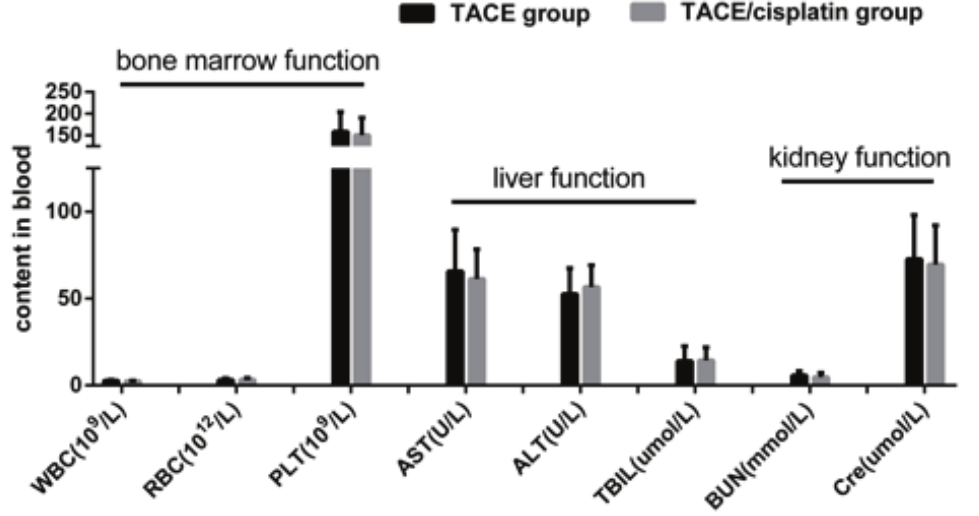
Figure 4: Blood detection of WBC (leukocyte), RBC (erythrocytes), PLT (platelets), AST (aspartate aminotransferase), ALT (alanine aminotrans- ferase), TBIL (total bilirubin), BUN (Urea nitrogen) and Cre (creatinine) in the TACE group and the TACE/cisplatin